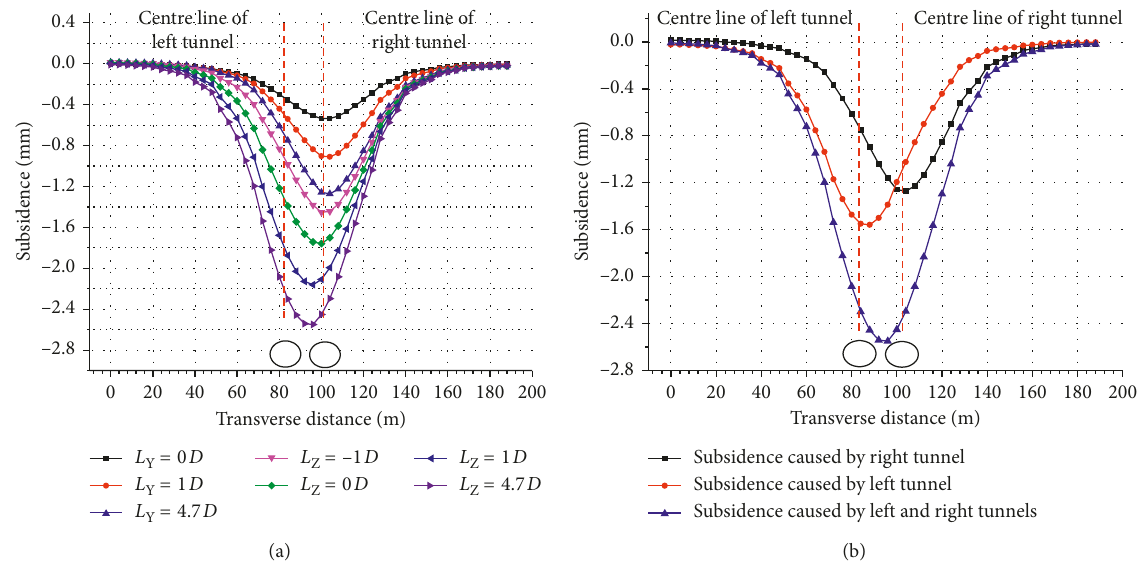
Figure 15: Monitoring data: (a) surface subsidence process; (b) surface subsidence caused by left and right tunnel tubes.